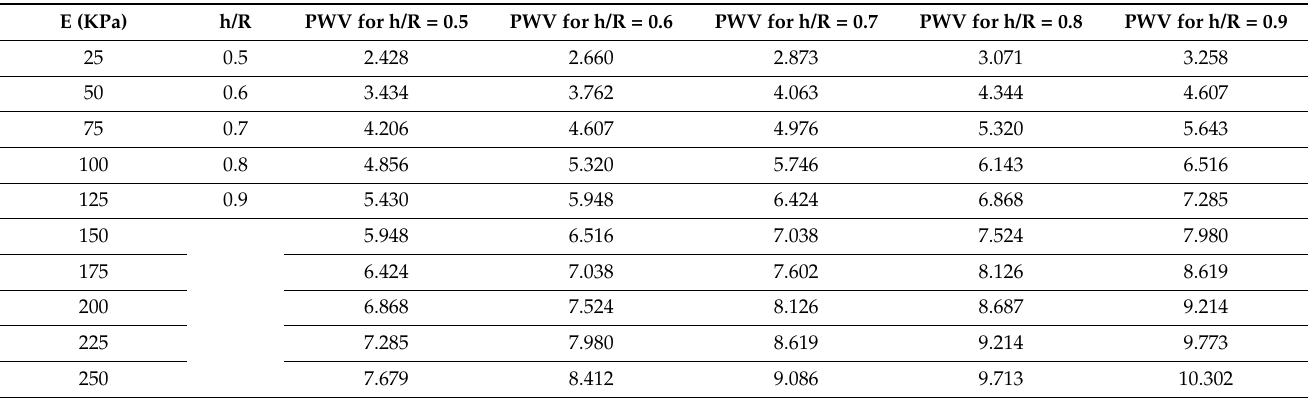
Table 7. Summary of PWV and E estimates for different values of thickness/radius ratios (h/r) after artery deformation due to blood